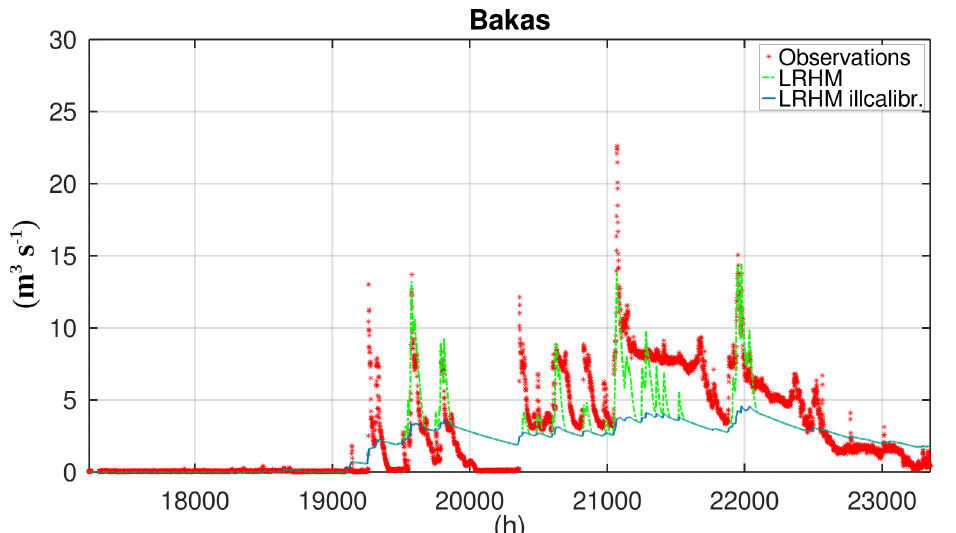
Figure 2. Application of LRHM in Bakas during its calibration period, corresponding intentionally ill-calibrated LRHM model and observations.